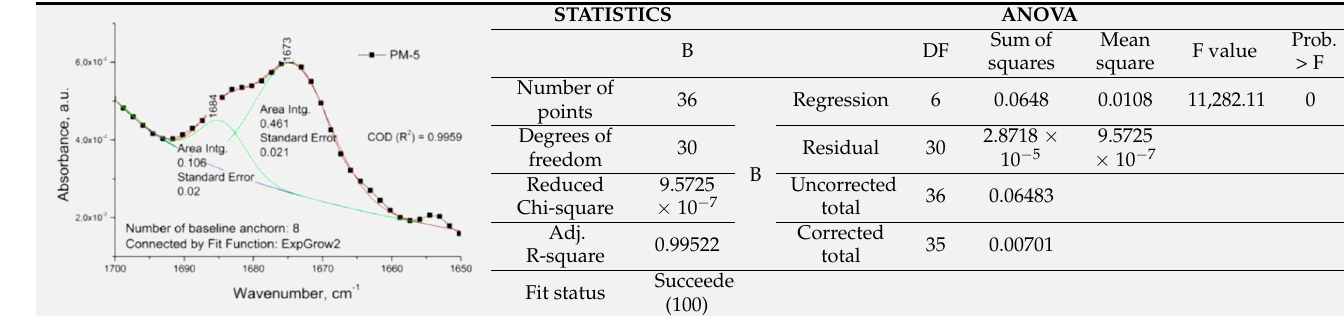
Table A1. Sample P-5.